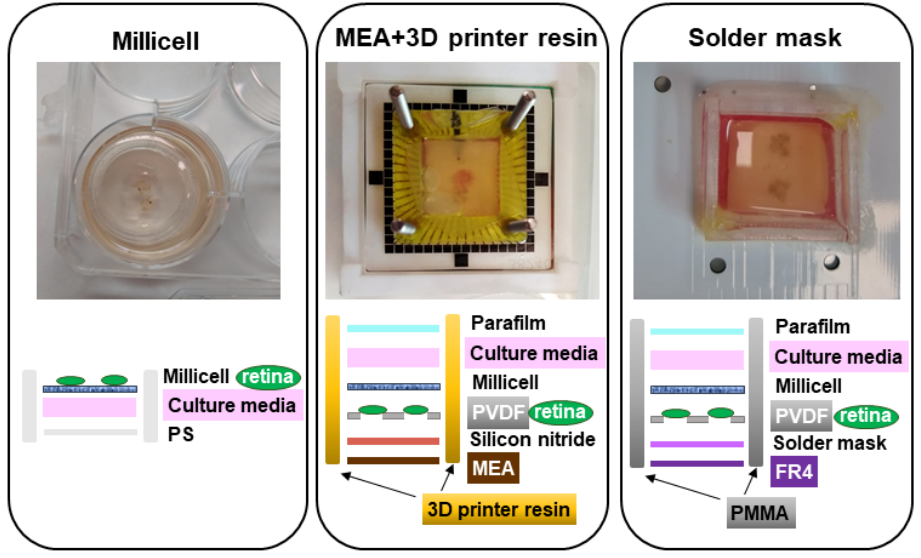
Figure 2. Images of the three different open culture systems and schematic representation of the setting for each case.